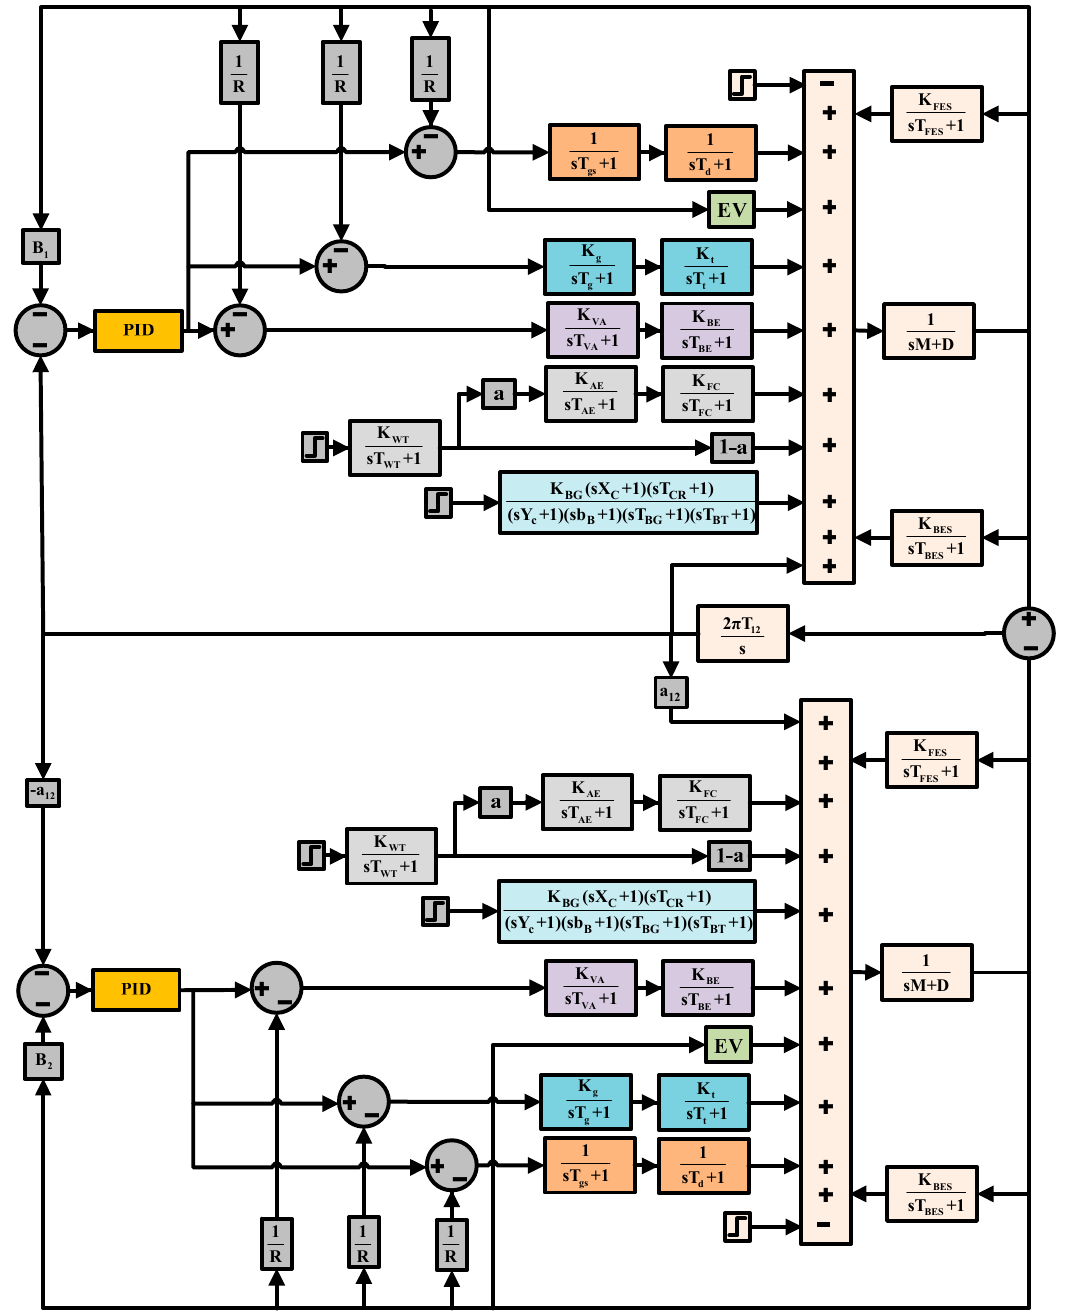
Figure 4. The micro-grid system under investigation.